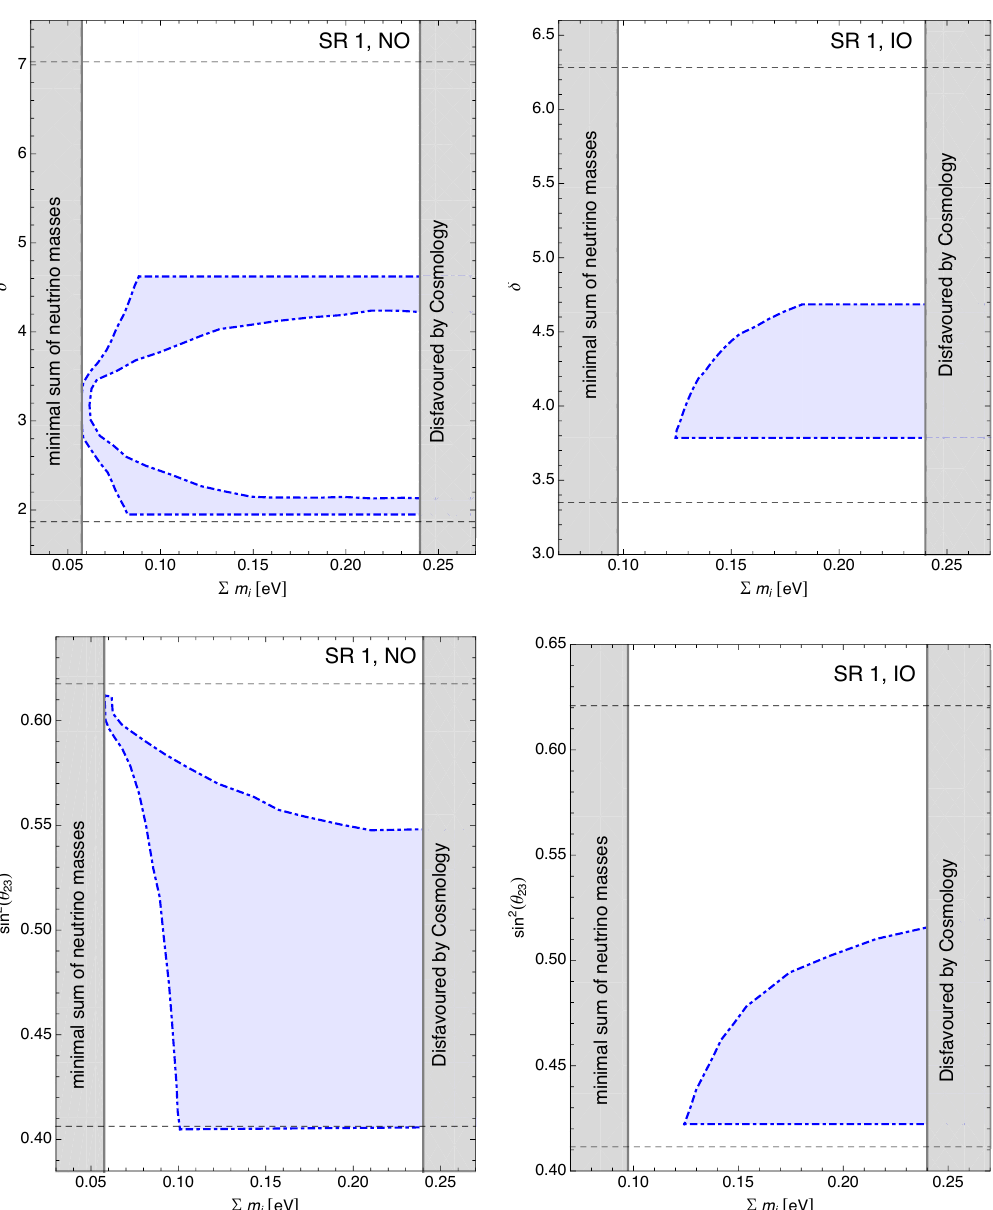
Figure 3 . Correlation between δ (upper plots) or sin 2 θ 23 (lower plots) and the sum of the neutrino masses in SR 1 for NO (left plots) and IO (right plots) for θ, φ and the mass splittings in their 3 σ ranges. The black dashed lines show the 3 σ allowed region without sum rules for NO/IO. The gray exclusion regions show the minimal value of the sum of the neutrino masses from oscillation experiments and the maximal value of the sum of the neutrino masses from